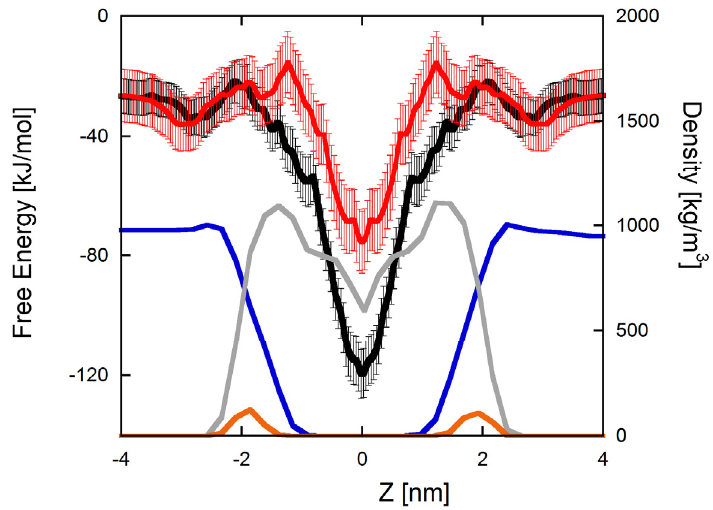
Figure 2. PMF profiles of the insertion of TempL (black) and Q3K-TempL (red) into a bilayer formed by Lipid-A. As reference, the density profiles of different parts of an unperturbed lipid-A bilayer are also reported. In particular, the water density profile is reported in blue and that of lipid tails and phosphate groups are reported in gray and orange, respectively. Roughly, the two peaks of the phosphates represent the boundaries of the membrane environment.